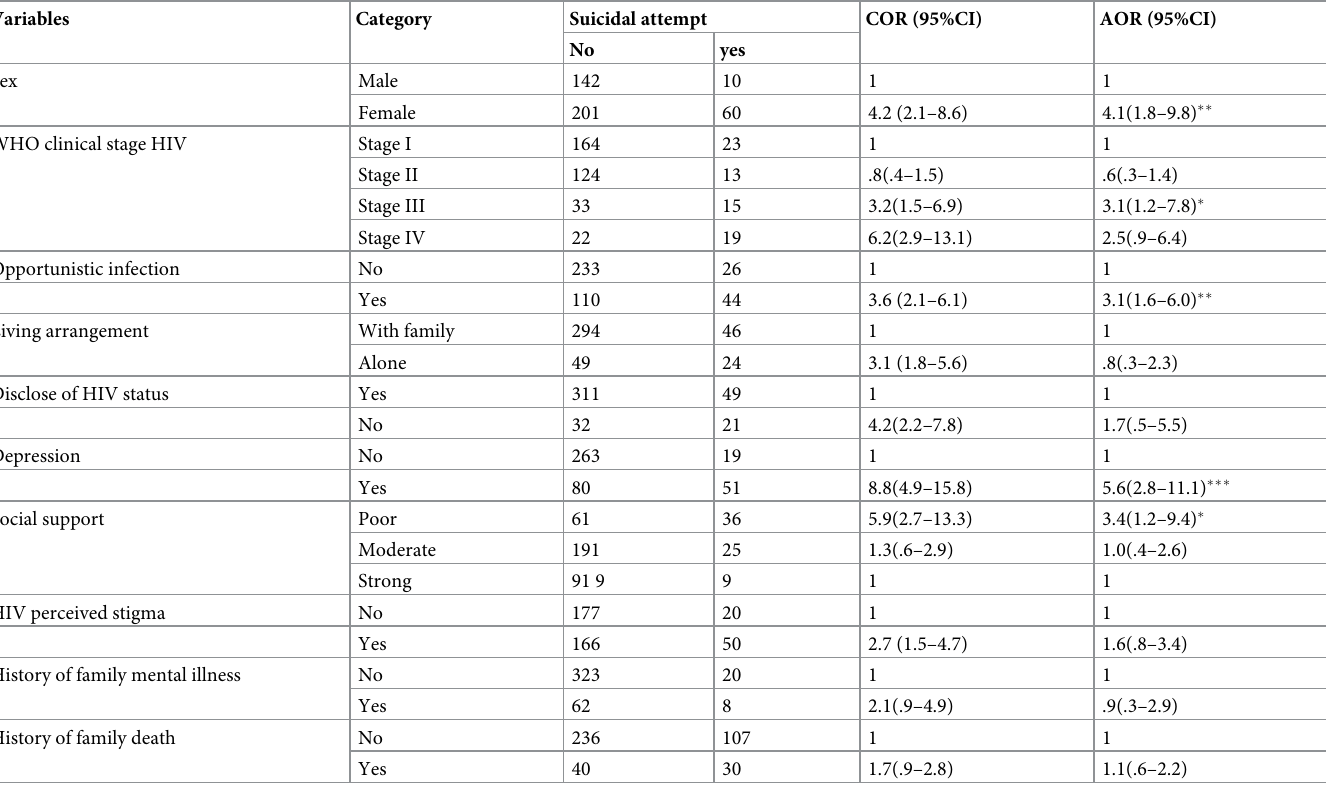
Table 5. Factors associated with a suicide attempt of participants at SPSH and SPHMMC Addis Ababa, Ethiopia, 2018 (n =